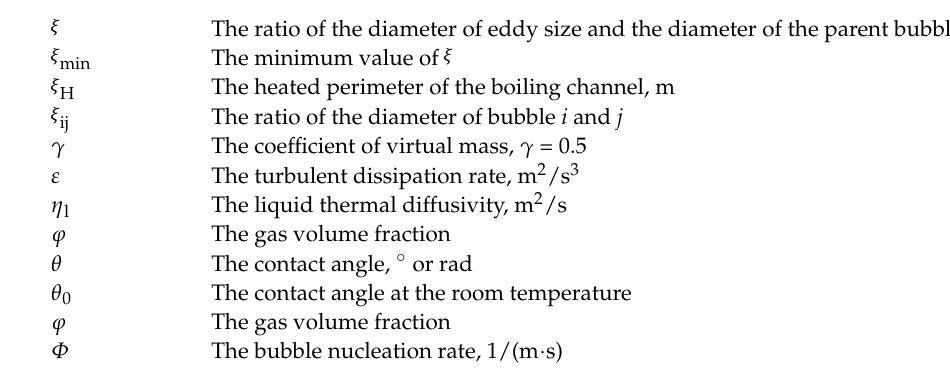
Table 5. Typical kernels of bubbles coalescence rate. Author/Year Collision Frequency h ( d i , d j ) Coalescence Efficiency λ ( d i , d j